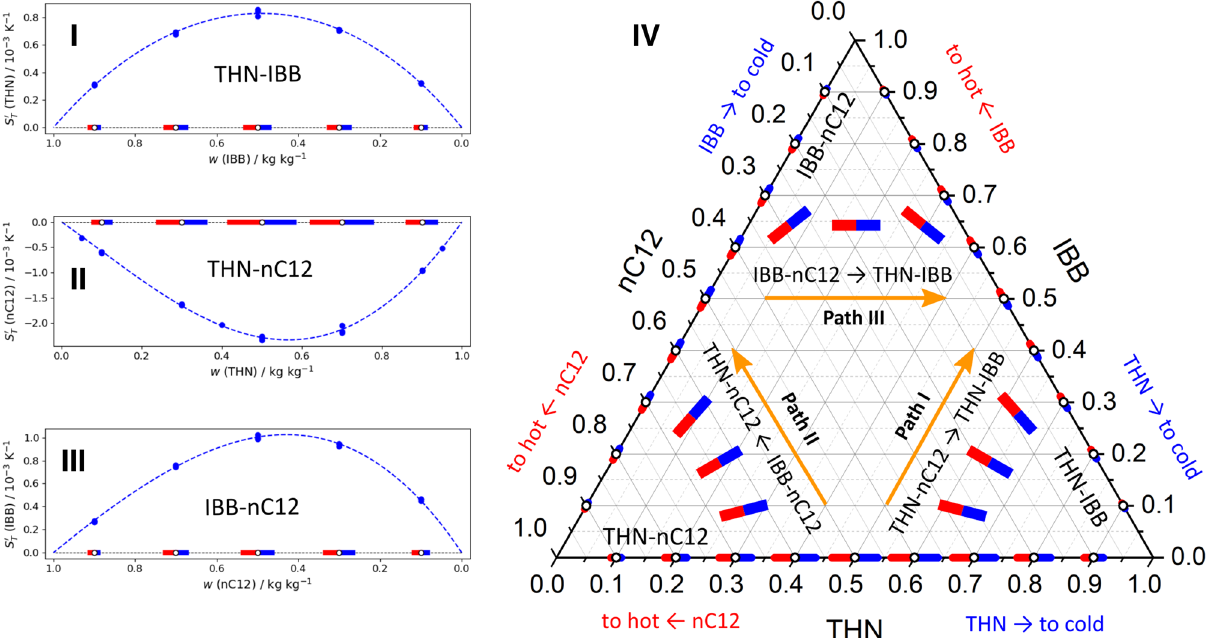
Figure 2. The Soret vectors in binary subsystems of the ternary mixture THN–IBB–nC12 are shown individually, ( I ) THN–IBB; ( II ) THN–nC12; ( III ) IBB–nC12, and on the sides of the Gibbs triangle (in mass fraction units). Paths ( I – III ) trace the Soret coefficients of THN, nC12 and IBB, respectively. The vectors on all the sides are plotted according to measurements and using the same scale. White circles indicate to which state point corresponds the vector. The vectors inside a ternary plot without an open circle in the center display the expected orientation and not in scale. The order of components in each binary subsystem corresponds to decreasing density and, for clarity, they are also written in gray